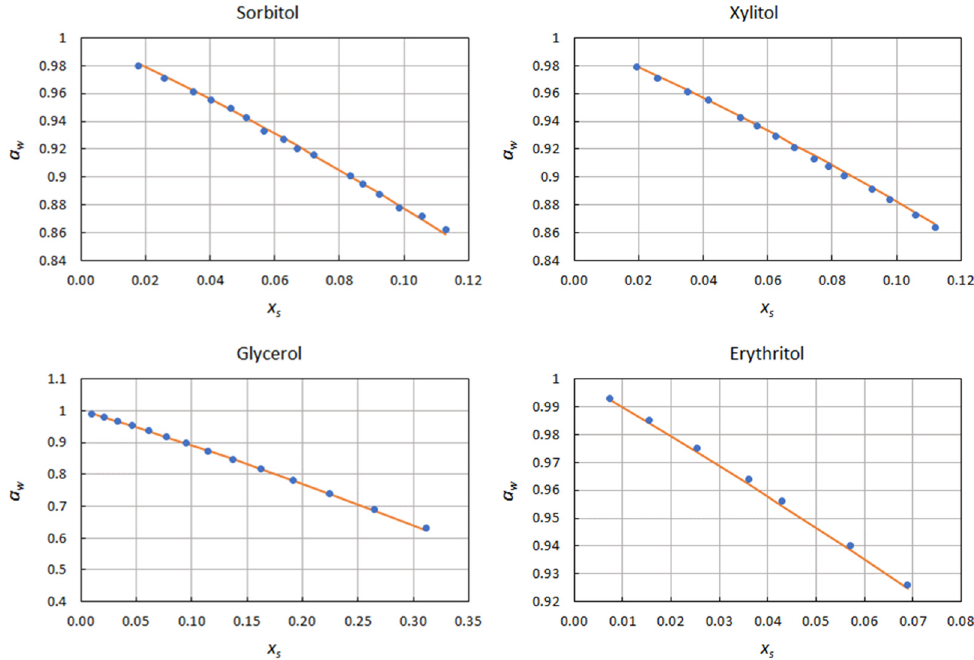
Figure 3. Water activity curves in the presence of polyols predicted by Equation (10), and comparison with the experimental data points.